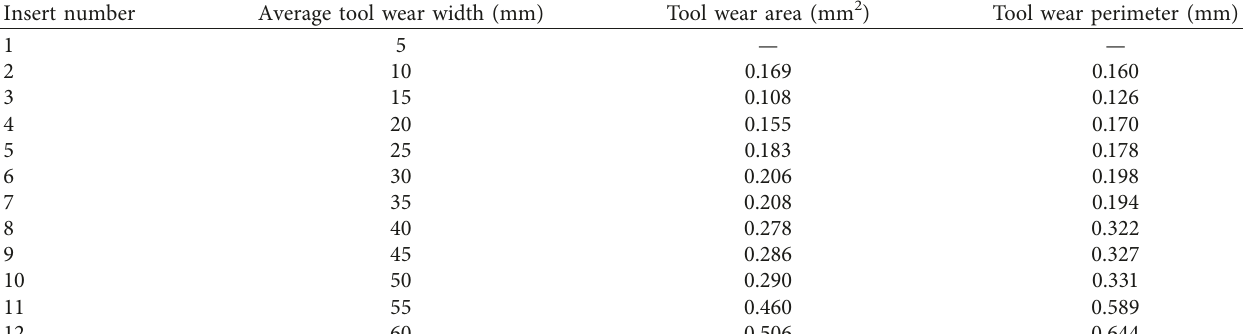
Table 4: Measured parameters of the tool wear with the vision